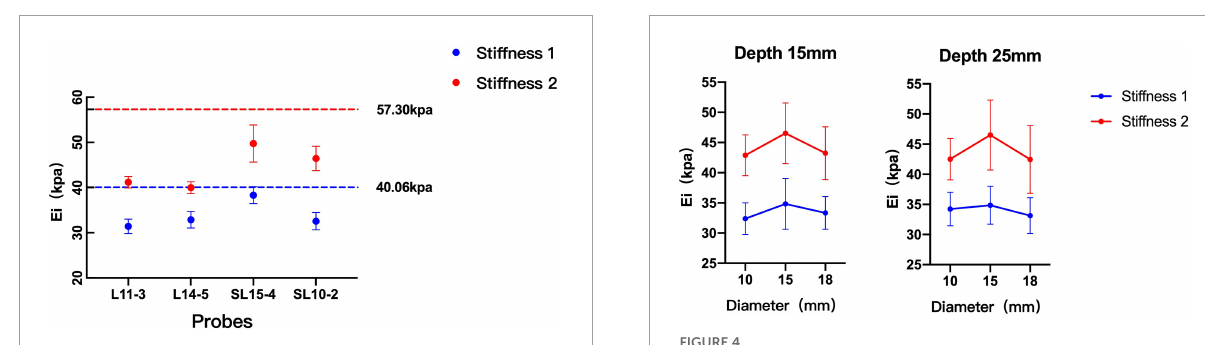
FIGURE4 Comparison of shear wave elastography (SWE) measurement values of three diameter phantom subjects under different stiffness and depth. The measurements of 15 mm diameter phantom subjects were greater than 10 and 18 mm diameter phantom subjects.